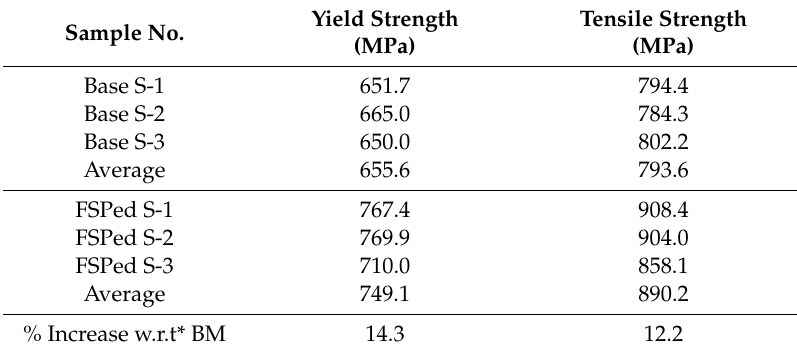
Figure 12. Fractured tensile sample: ( a ) BM, ( b ) FSPed metal. Figure 11. Typical tensile stress ‒ strain curves of BM and friction stir processed (FSPed) 2507 SDSS. Table 3. Tensile behavior of BM and FSPed 2507 SDSS.